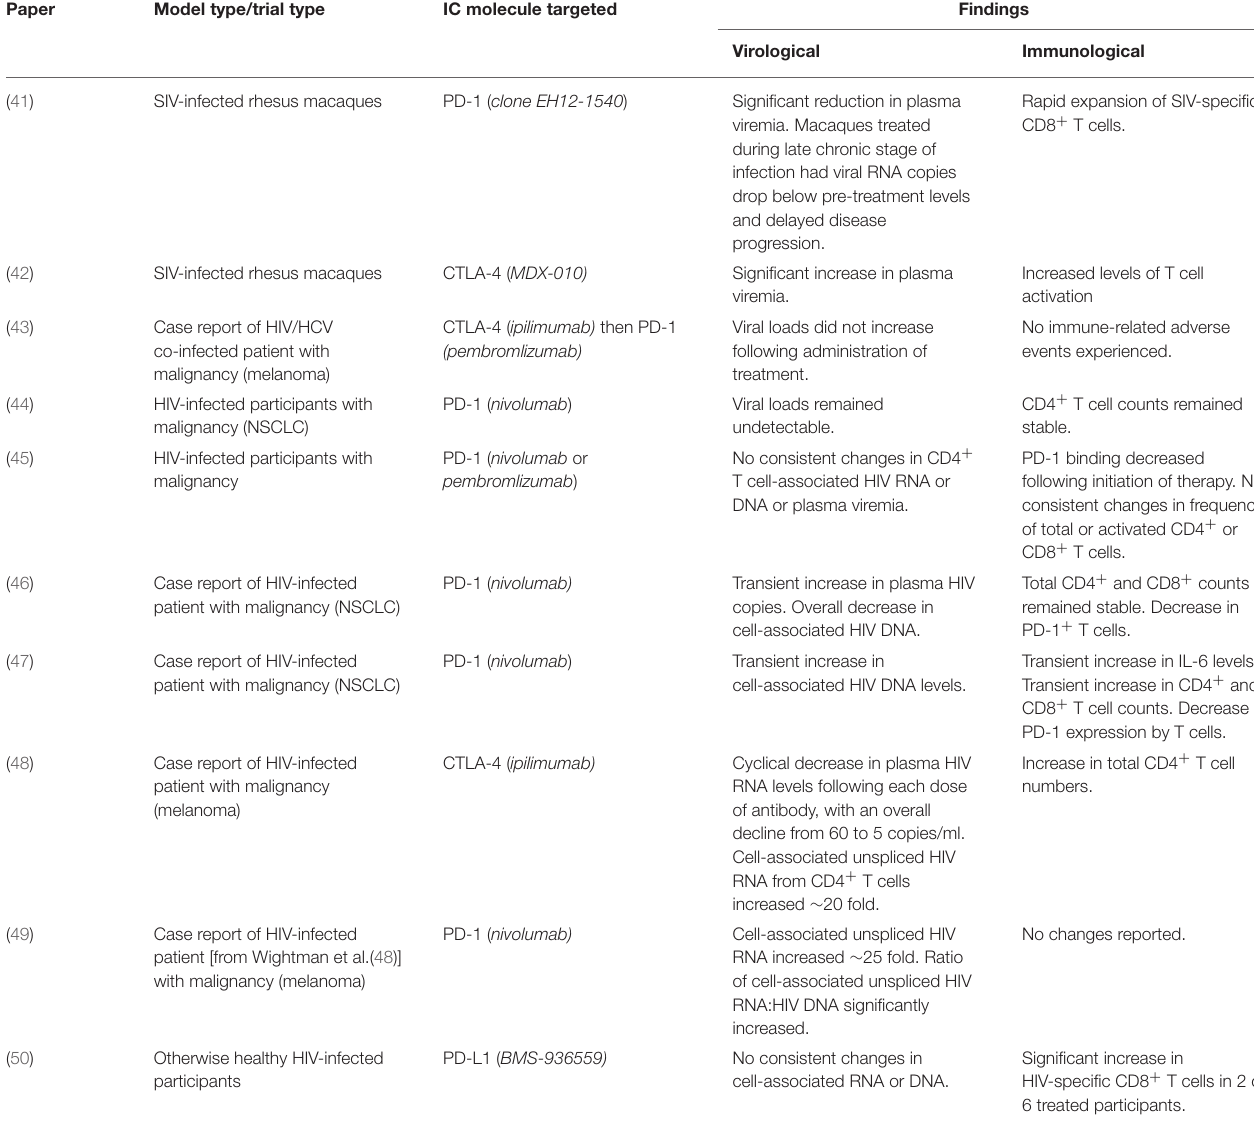
TABLE 1 | Summary of published trials and case-reports investigating immune checkpoint inhibitors in